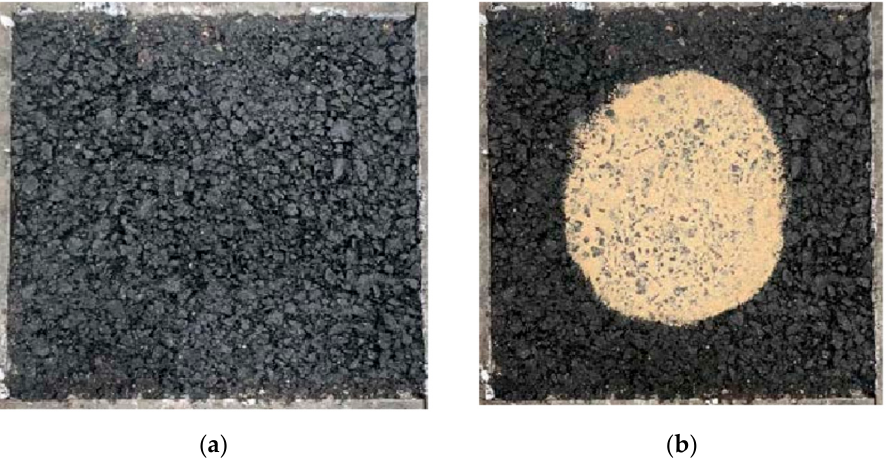
Figure 5. Surface topography of surface layers and mean texture depth test: ( a ) rutting test specimens; ( b ) mean texture depth (MTD) test area.